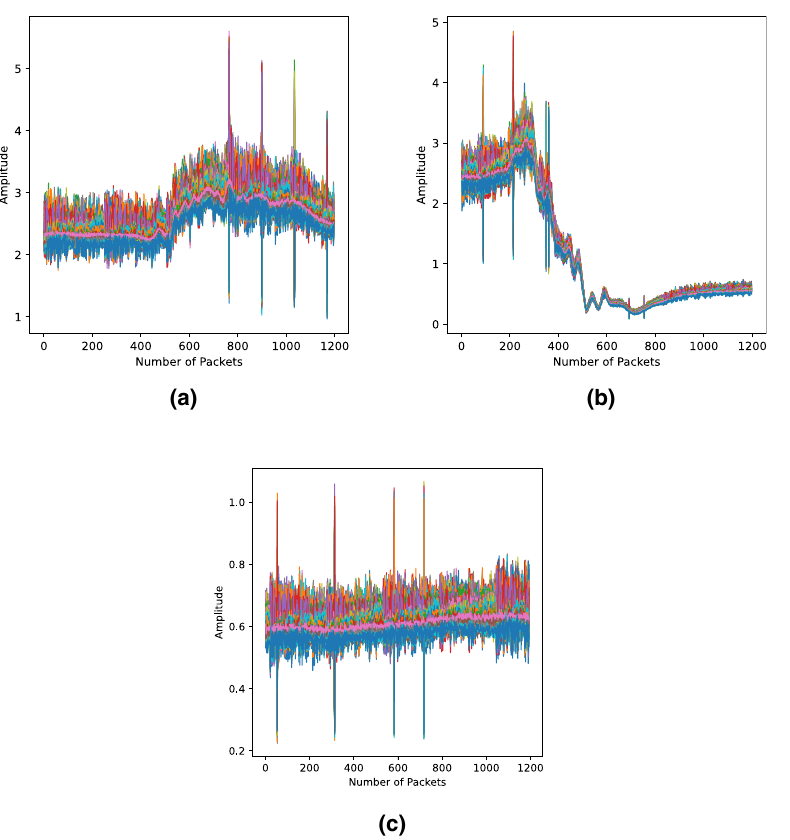
Figure 1. Channel state information patterns of activities performed at 5 GHz (Wi-Fi frequency) and 3.75 GHz (5 G Frequency); ( a ) Standing Activity at 5 GHz, ( b ) Standing Activity at 3.75 GHz, ( c ) Empty Room at 5